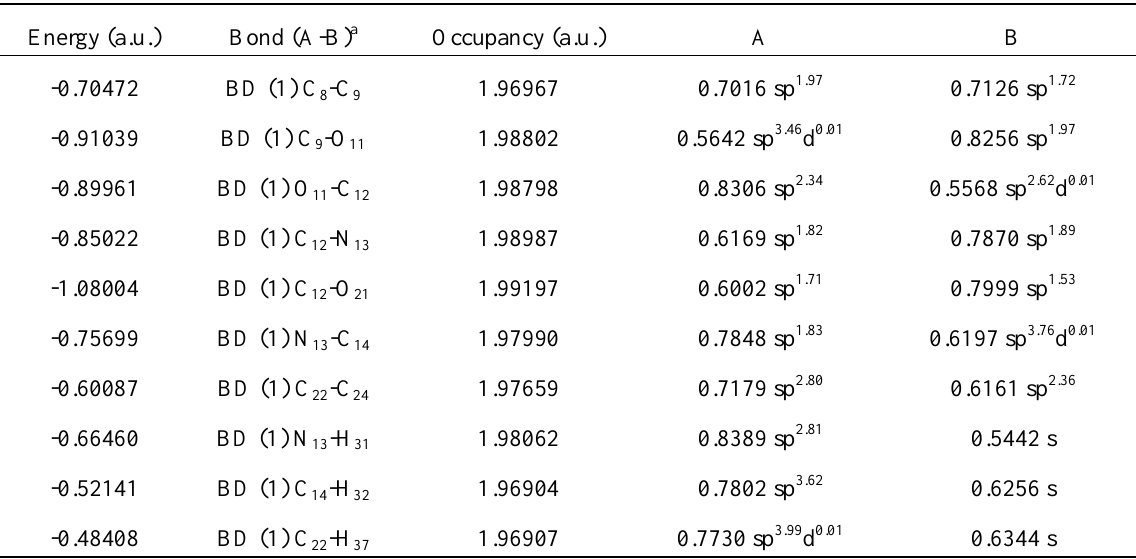
Table 8. Calculated Natural Bond orbitals (NBOs) and Polarization Coefficient for Each Hybrid in Selected Bonds of 4i Compound at B3LYP/6-311+G* Level (Atom Labeling Corresponds to Fig. 7)